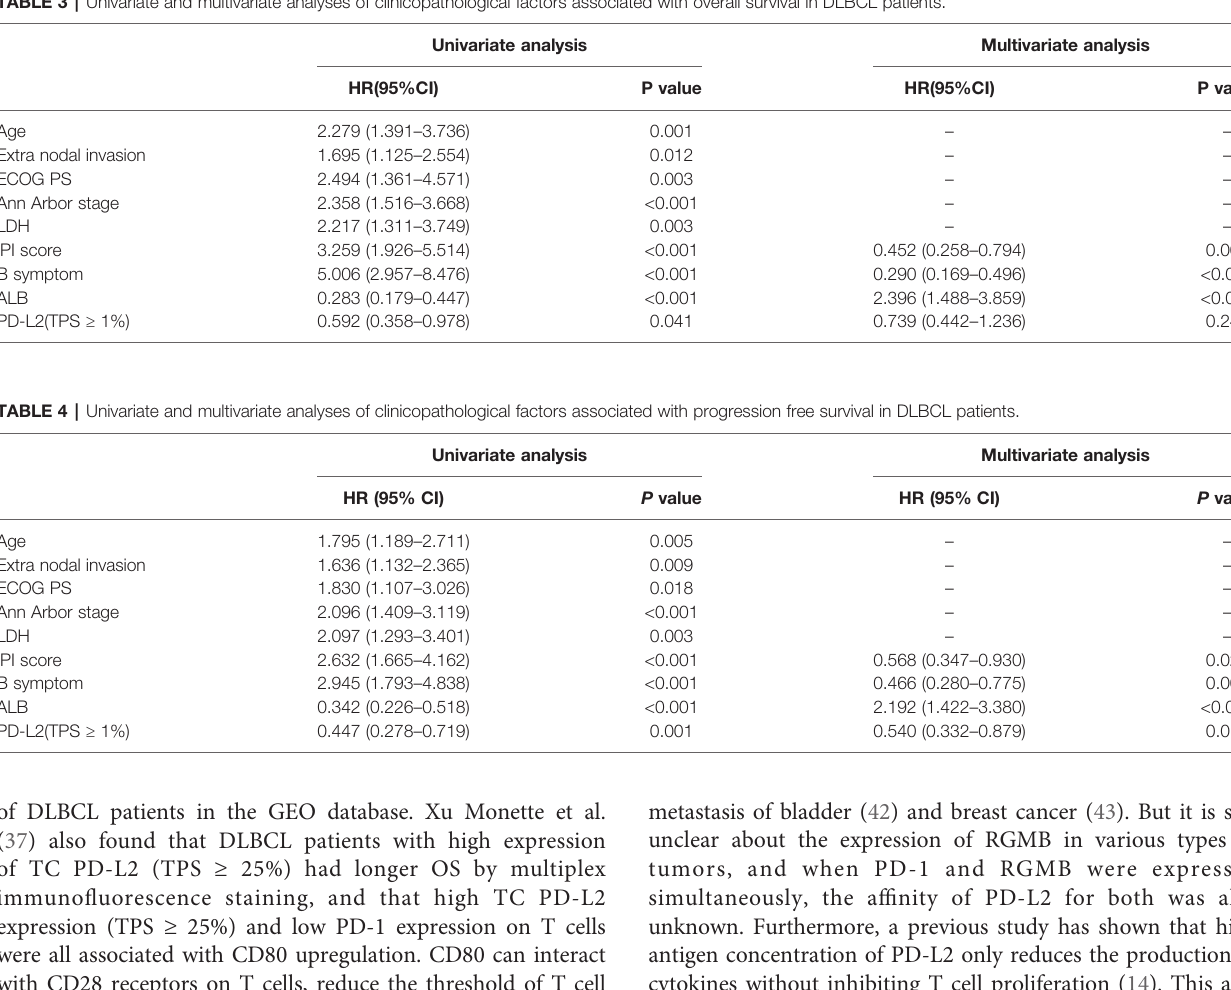
TABLE 3 | Univariate and multivariate analyses of clinicopathological factors associated with overall survival in DLBCL patients.